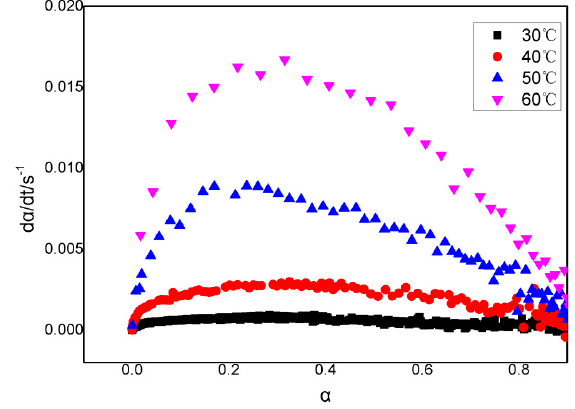
Figure 3. The relationship curve between the curing rate and the curing degree of GAPSPs.